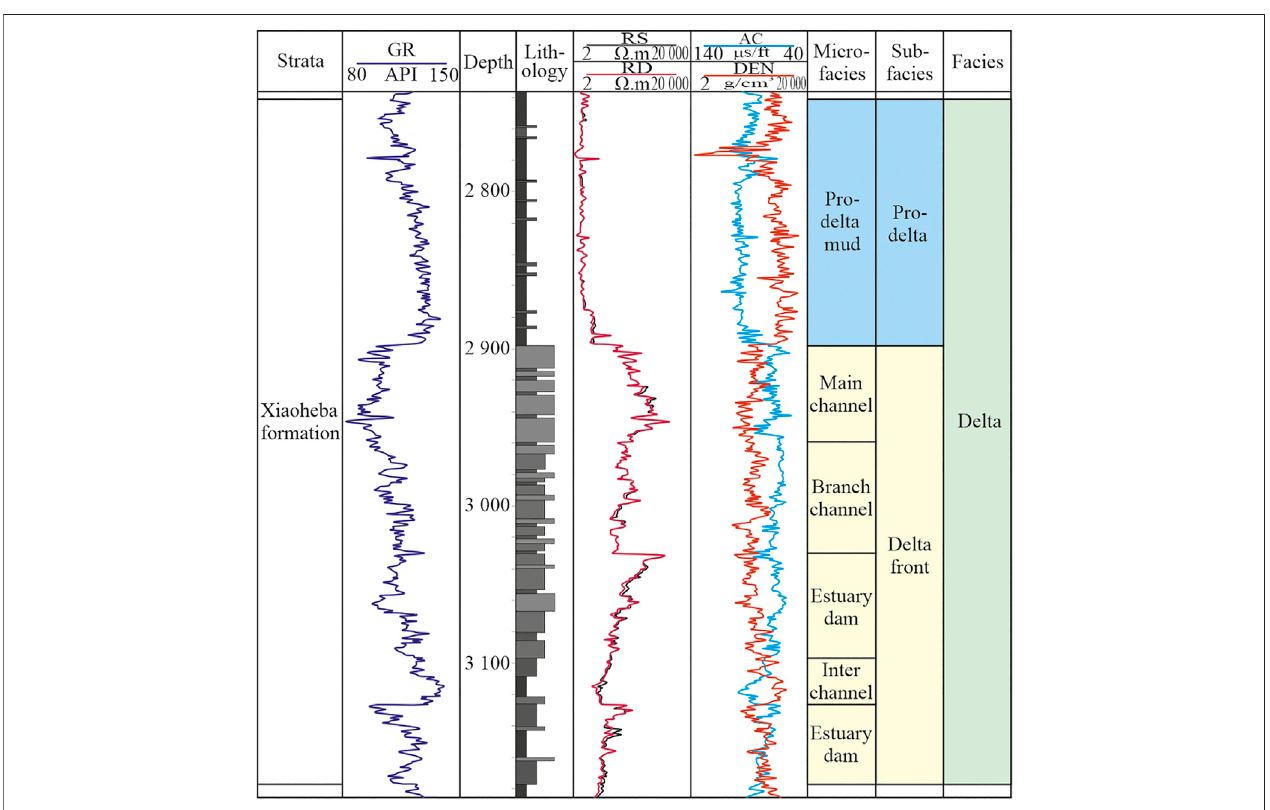
FIGURE 3 | Composite histogram of Xiaoheba Formation in study